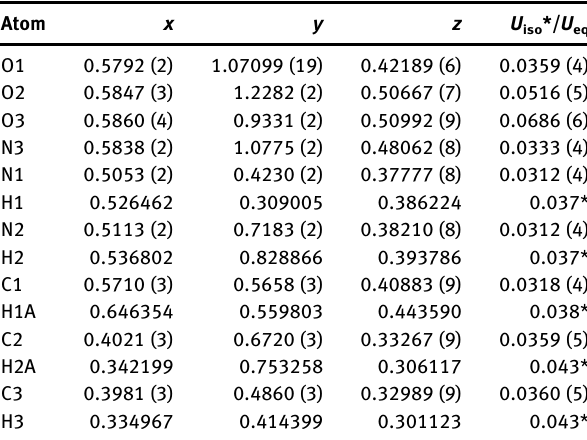
angles within these moieties are in the expected ranges [8]. Both ions arealmost fl atandthedihedralanglebetween their planes is 35.1 ° . N – H ⋯ O hydrogen bonds connect the cations and anions to chains along the b-axis (see the fi gure) and the dihedral angle is 35.120 ° .